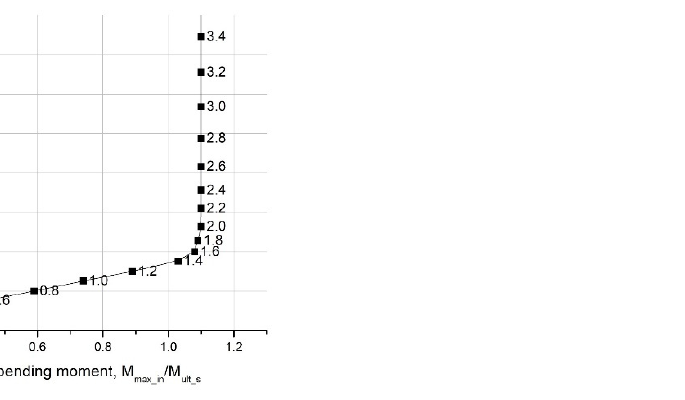
Figure 11. Internal bending moment and vertical displacement for mid-span box girder M2 at load duration time T d = 0.005 s (Data label denotes M d /M ult_s ).